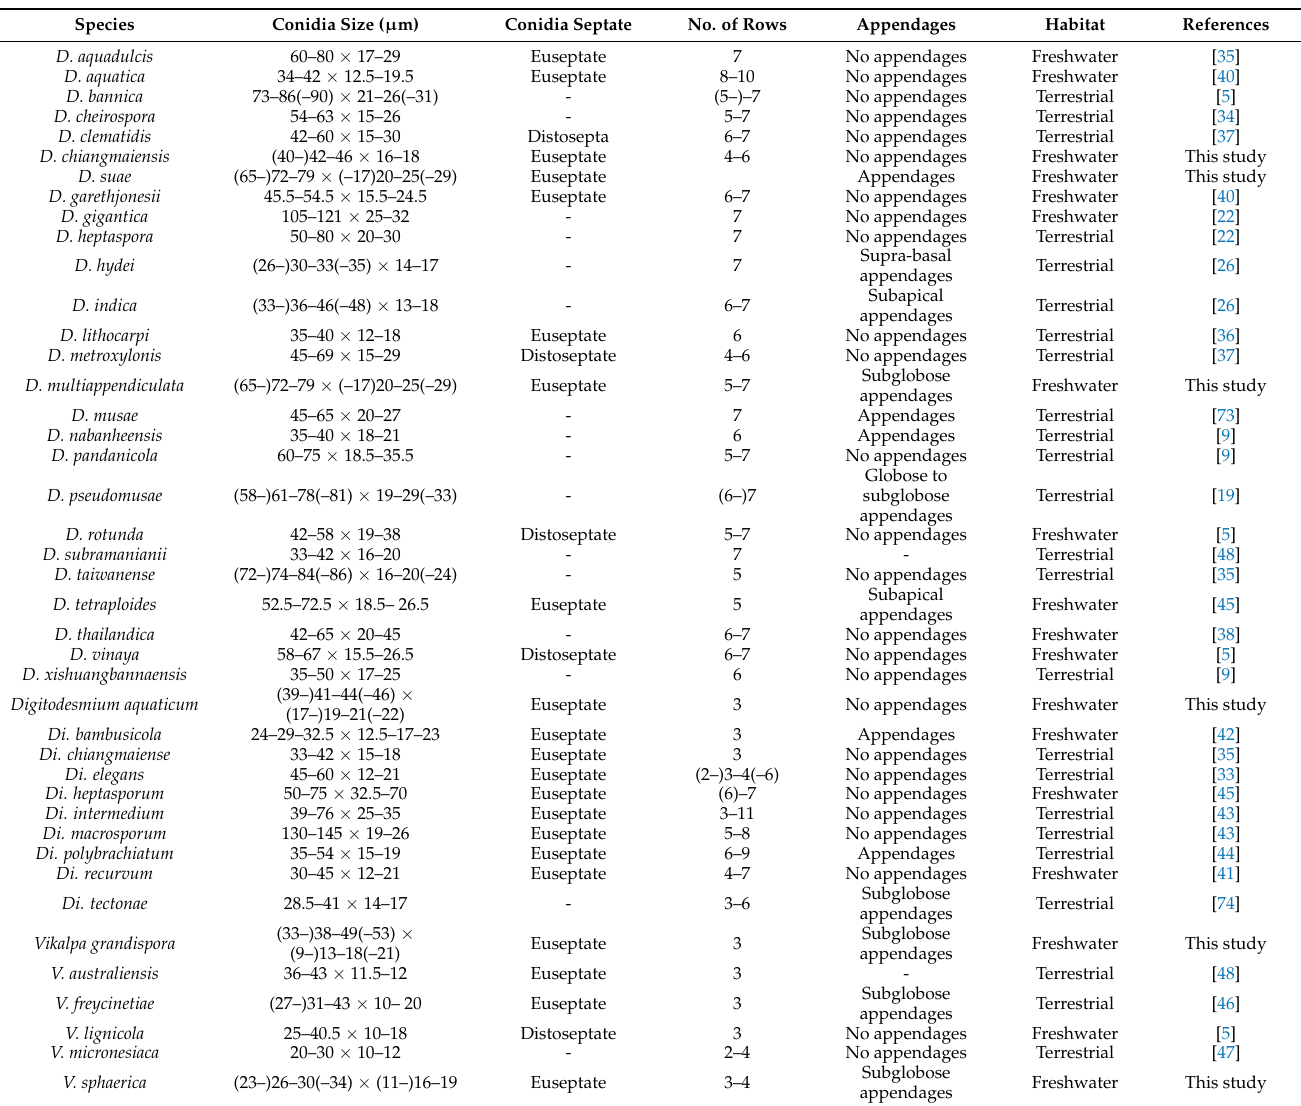
Table 2. Comparison of conidia characteristics and habitats of Dictyocheirospora , Digitodesmium and Vikalpa